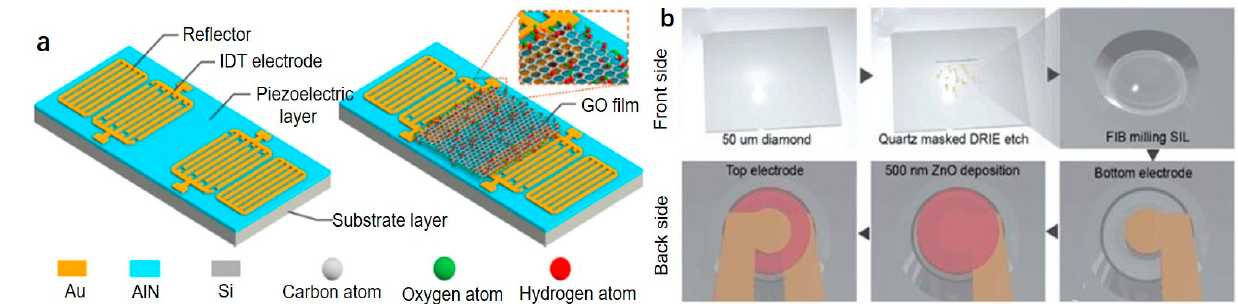
Figure 10. SAW/BAW resonator. ( a ) Aluminum nitride surface acoustic wave humidity sensor with GO film. Adapted with permission from [105]. ( b ) Schematic diagram of the front and back side manufacturing of the SCHBAR. Adapted with permission from [110].